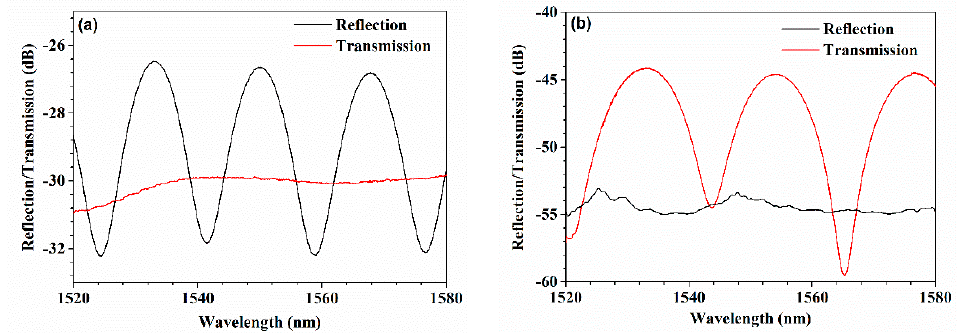
Figure 3. Spectra of the fiber with an inner air-cavity ( a ) before and ( b ) after tapering.